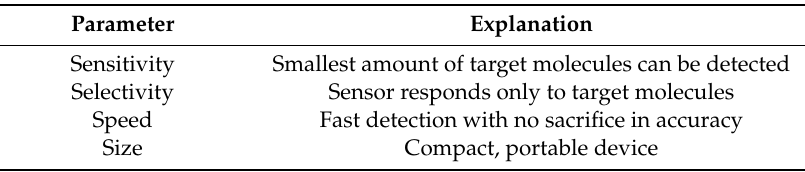
Table 4. E ff ective parameters in biosensor Table 4 . Effective parameters in biosensor performance .